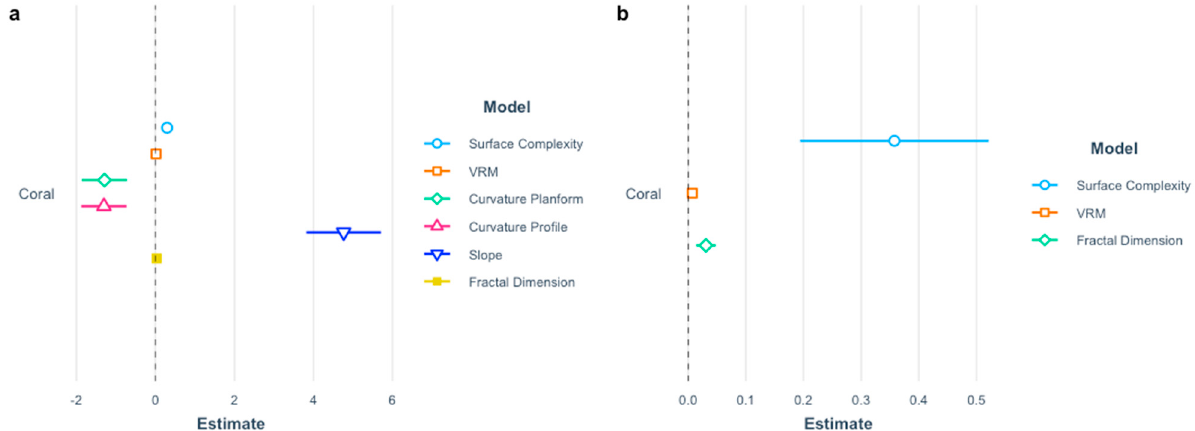
Figure 5. Univariate generalized mixed effects models examining the influence of live coral cover on metrics of habitat complexity at ( a ) natural reef sites ( b ) and UCH sites. Live coral was used as a predictor variable and tested against each metric of 3D habitat complexity. The beta coefficient estimates represent the strength and direction of the relationship between live coral cover and each 3D metric.